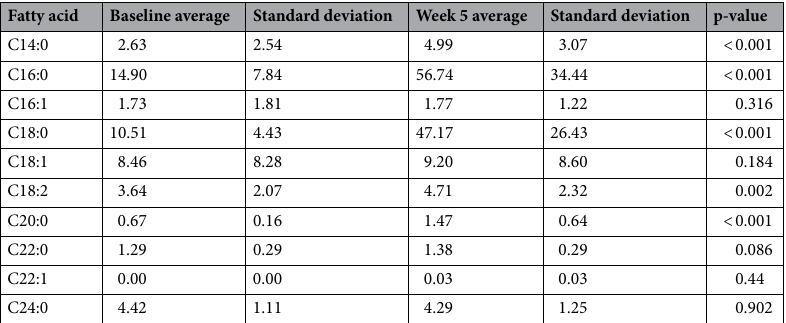
Table 1. Levels of free fatty acids. Average levels are given for each fatty acid species measured in pmol/µg. A mixed effects model was used to assess the differences between timepoints.